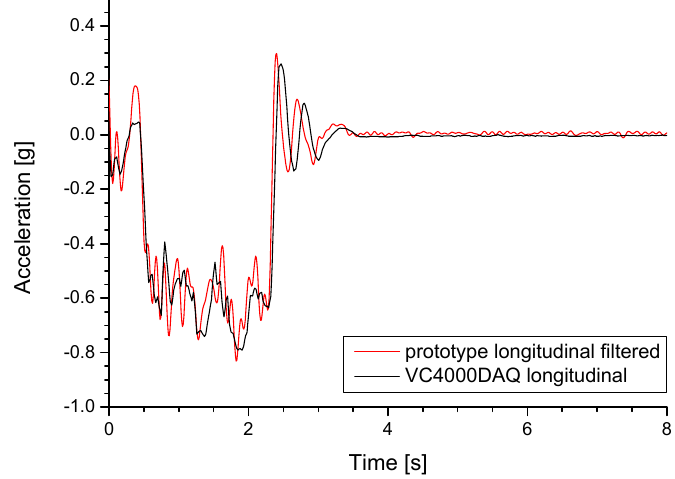
Figure 7. Preliminary test with 10 HZ low-pass filter applied to prototype accelerometer signal.